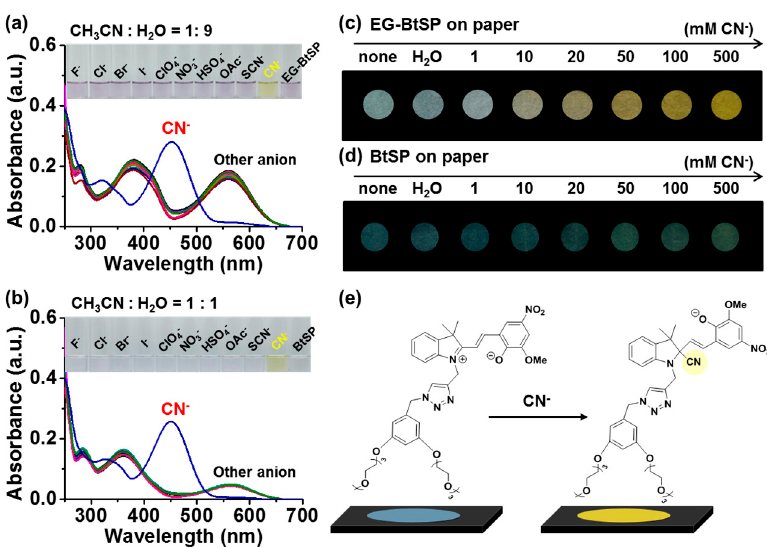
Figure 3. ( a , b ) UV-VIS absorption spectra of EG-BtSP (a, 2 × 10 − 5 M) and BtSP (b, 2 × 10 − 5 M) measured with 50 equiv. of respective anion (as a n -Bu 4 N + salt) in a water/CH 3 CN mixture (9:1 or 1:1 v / v ) at 25 °C. The spectra were obtained 30 min after addition of the anion to the SP solution. Photographs of the solutions were also presented: from left F − , Cl − , Br − , I − , ClO 4 − , NO 3 − , HSO 4 − , OAc − , CN − , without any anion; ( c , d ) Colorimetric changes of the papers with SP probes, EG-BtSP ( c ) and BtSP ( d ); upon the application of cyanide in H 2 O. From left to right: probe only, H 2 O, 1 mM, 10 mM, 20 mM, 50 mM, 100 mM, and 500 mM of cyanide; ( e ) Schematic illustration of paper-based colorimetric detection of cyanide with EG-BtSP.